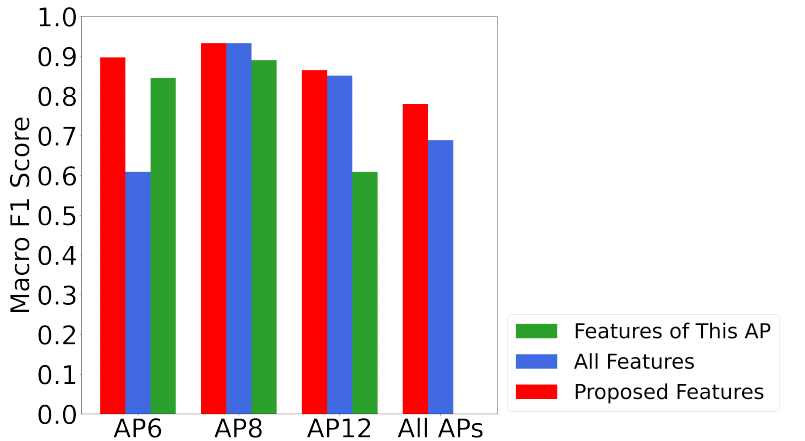
Figure 16. The performance of all APs and individual AP LOS identification using different sets of features. Please note that features included are all statistical features introduced in Section